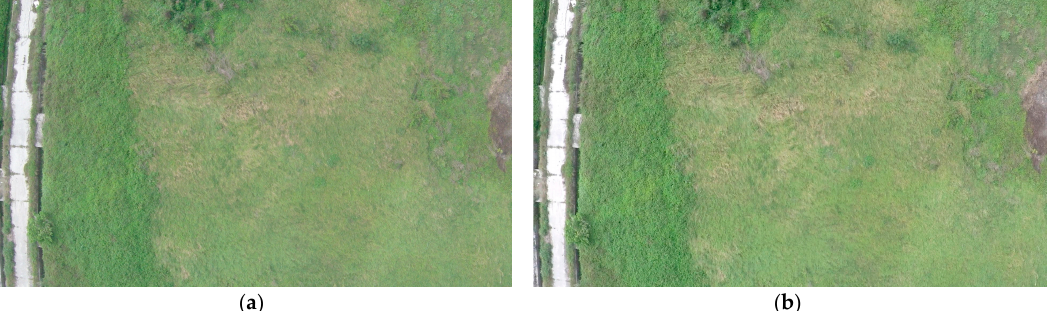
Figure 14. Comparison results in synchronization process ( a ) the original photo taken by Gopro camera and ( b ) video frame captured by synchronization program.